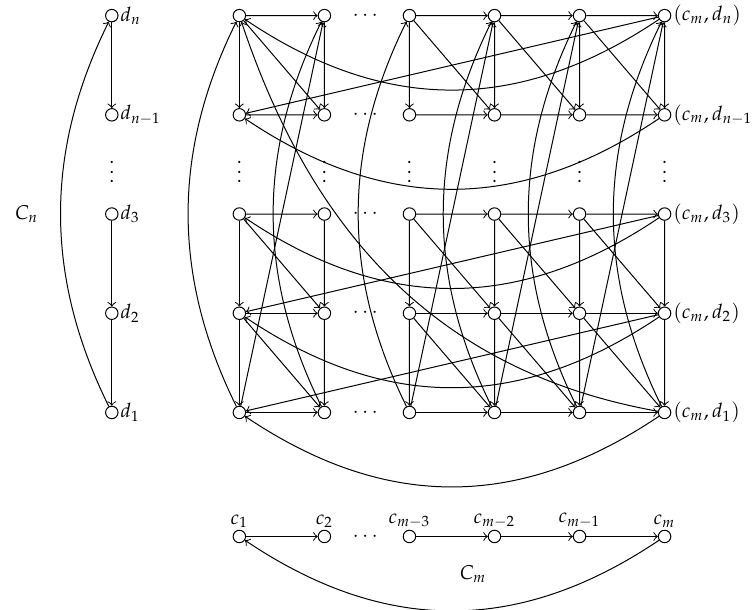
Figure 3. The strong product of two directed cycles C m and C n